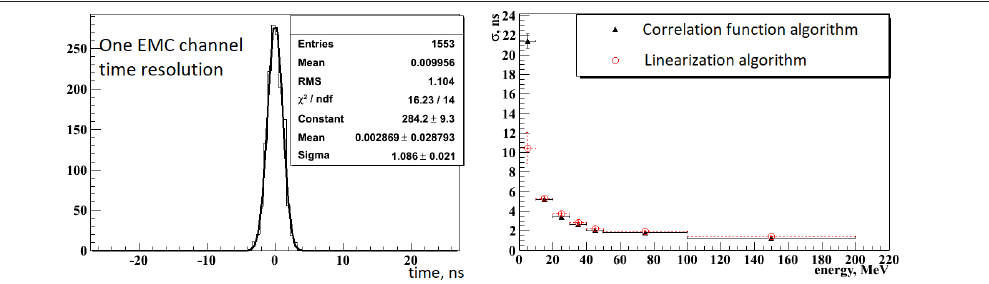
Figure 5. The correlation function algorithm results on e + e − → e + e − events. On the left - the obtained time resolution in one EMC counter on fitted signals with reconstructed energy deposition E > 100 MeV for the main time peak. On the right - time resolution dependence on EMC energy deposition for the same EMC counter obtained by two